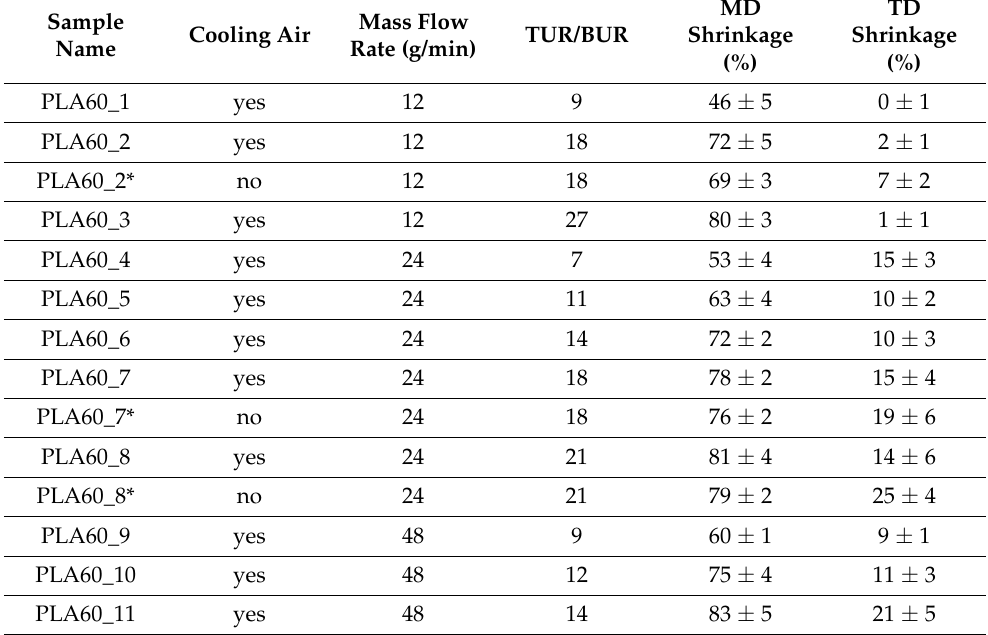
Table 4. Extrusion blowing parameters and thermal shrinkage for films made of PLA60 blend. Films with an asterisk are those produced without cooling